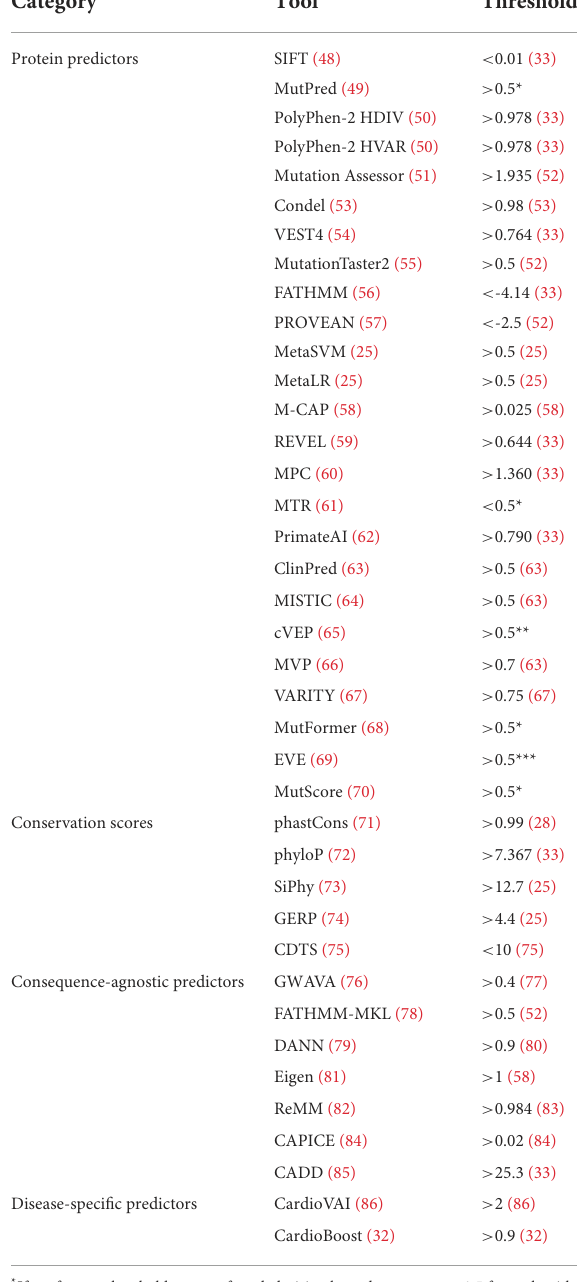
TABLE 1 Prediction tools analyzed in this